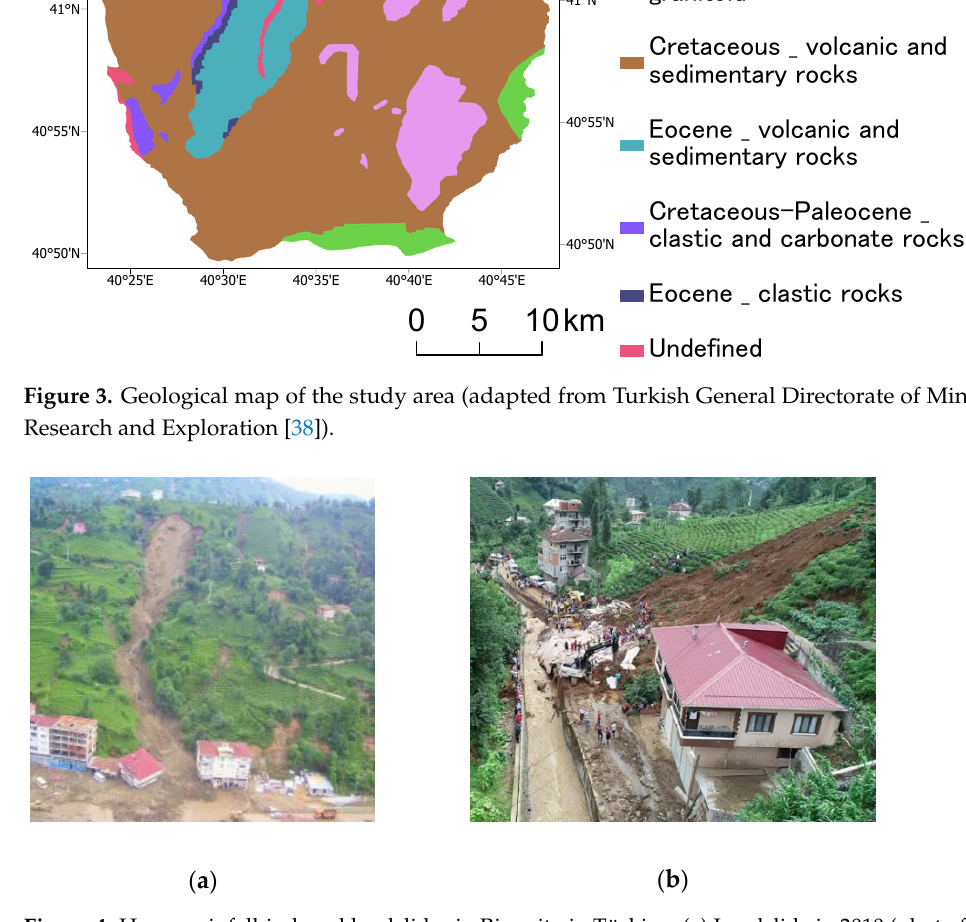
Figure 4. Heavy rainfall-induced landslides in Rize city in Turkey. ( a ) Landslide in 2010 (photo from Turkish Disaster and Emergency Management Directorate [39]). ( b ) Landslide in 2021 (photo from Turkish Disaster and Emergency Management Directorate [34]).